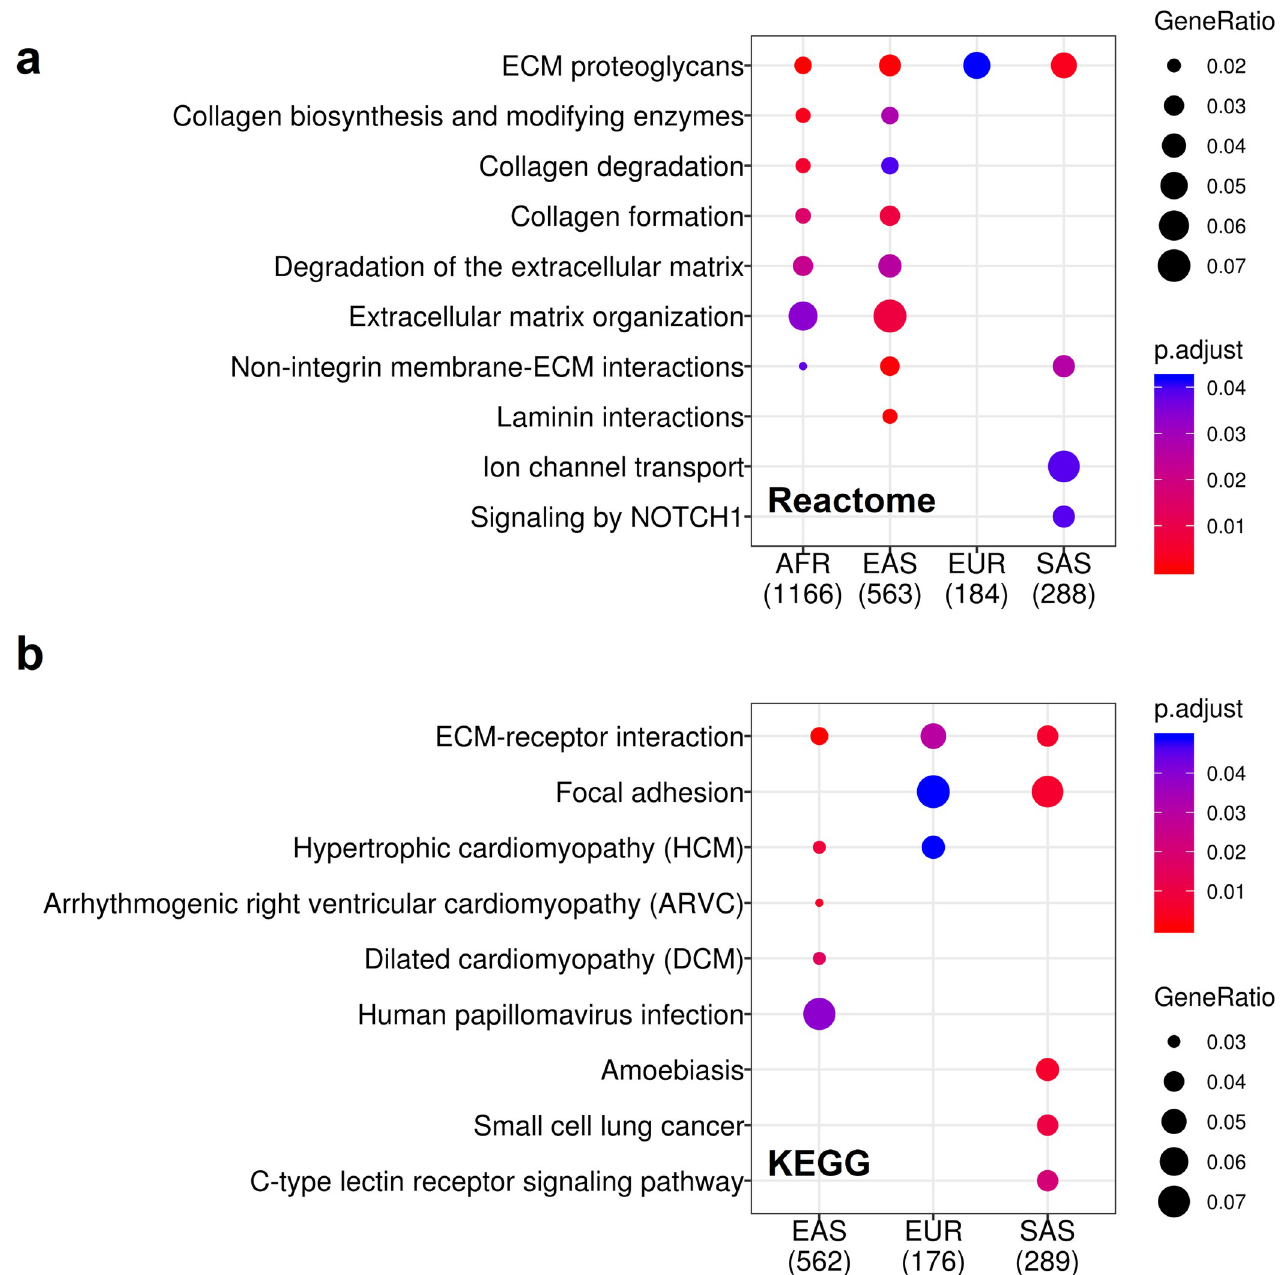
Fig 5. Reactome and KEGG pathways over-represented by genes harboring EBML for each super-population. a, The most significant Reactome pathways are those associated with the extra-cellular matrix (ECM) and collagen formation, degradation, and modification. b, The top two KEGG pathways–Focal adhesion and ECM-receptor interaction–are consistent with